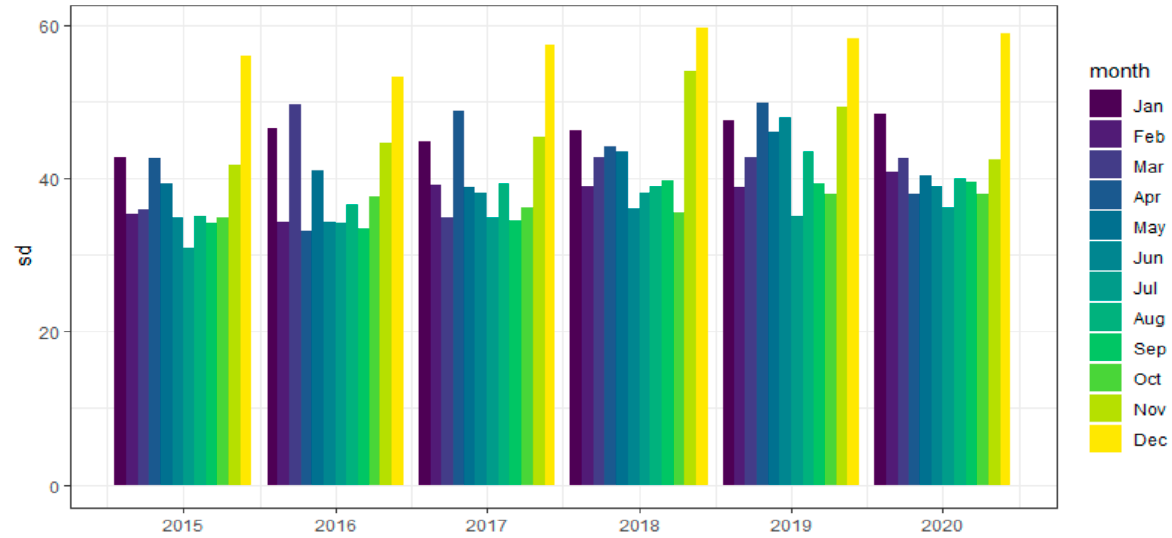
Figure 9. Daily consumption—standard deviation in months 2015–2020 (in GWh).